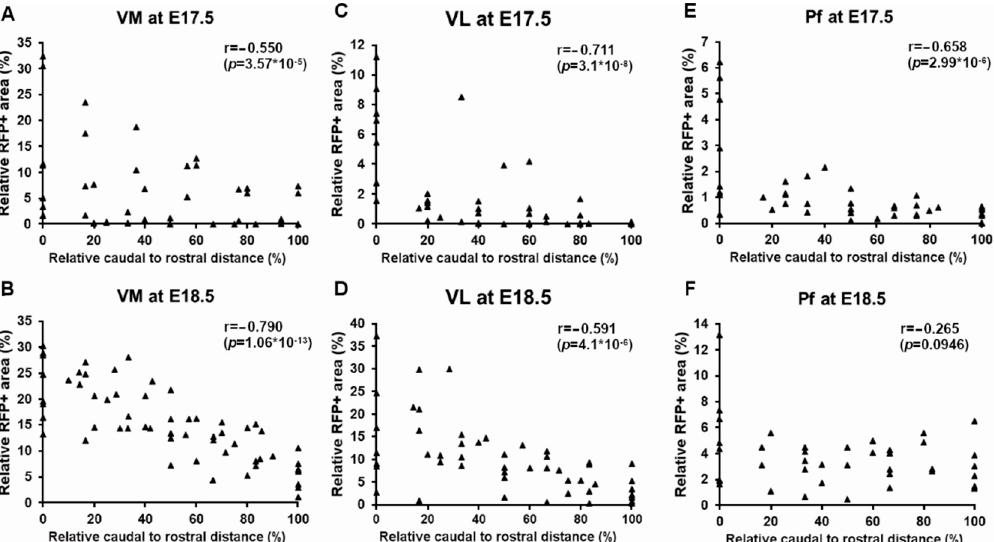
Figure 10. RFP signal quantification from caudal to rostral in the thalamic nuclei. The relative amount of RFP + fibers (in %) is plotted against the relative rostral to caudal distance (in %) in VM, VL and Pf. ( A , B ) VM at E17.5 (n = 48) and E18.5 (n = 57), respectively, ( C , D ) VL at E 17.5 (n = 46) and E18.5 (n = 52), respectively, ( E , F ) Pf at E17.5 (n = 39) and E18.5 (n = 39), respectively. r = Spearman’s rho.